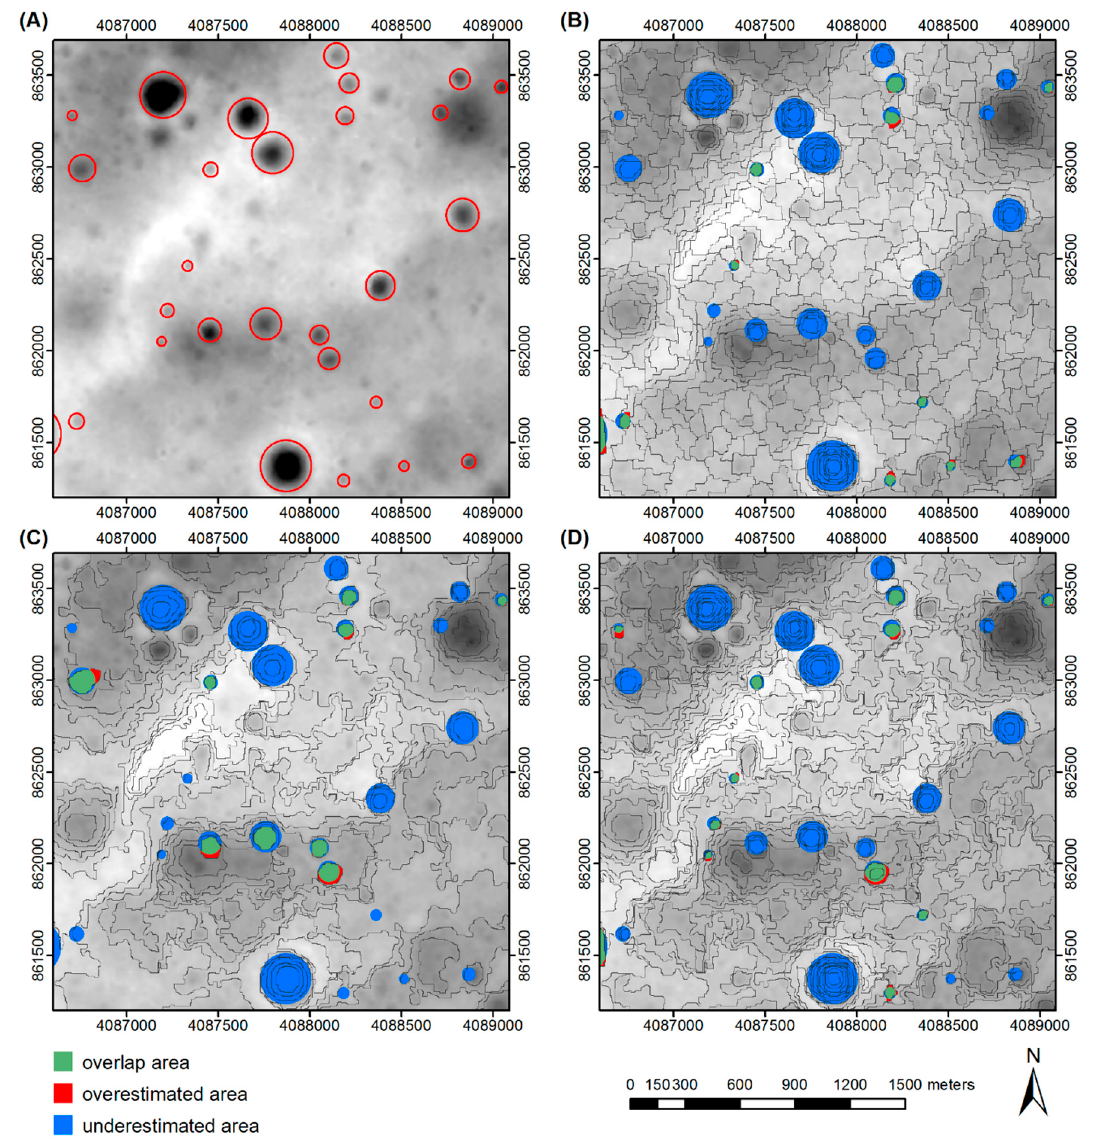
Figure 7. ( A ) Reference impact crater polygons overlapping the 5 m DEM (in red). ( B – D ): The intersection maps with classified areas of overlap, over- and under-estimation of objects produced by ( B ) MRS ( SP global = 10), ( C ) Global ( SP global = 30), and ( D ) Local ( SP global = 10).